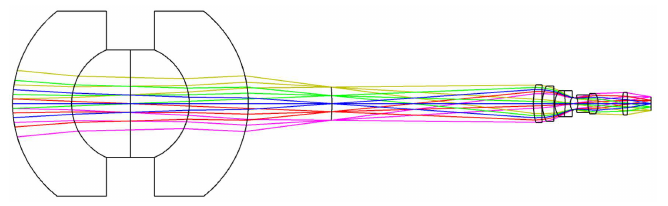
Figure 9. Image-space telecentric concentric multi-scale optical system layout.